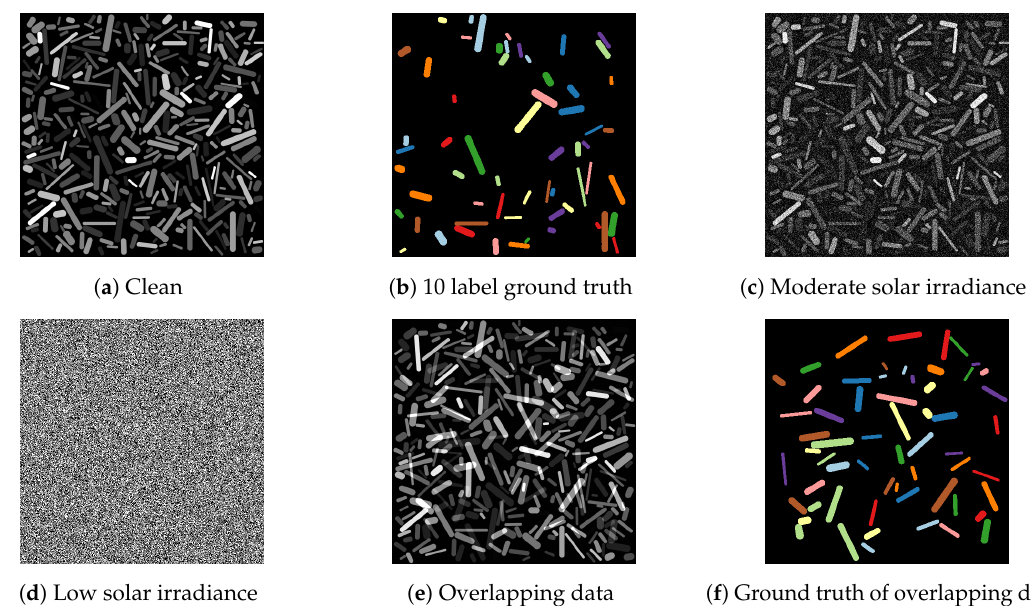
Figure 12. Visualization of the simulated remote sensing data. The clean data and the ground truth are shown in ( a , b ), respectively. When the described Gaussian noise is added to this data, many bins still resemble the clean data, but ( c ) shows a moderately noisy bin and ( d ) shows an extremely noisy bin, resulting from differences in solar irradiance. The data with overlapping cylinders and their representation as ground truths are given in ( e , f